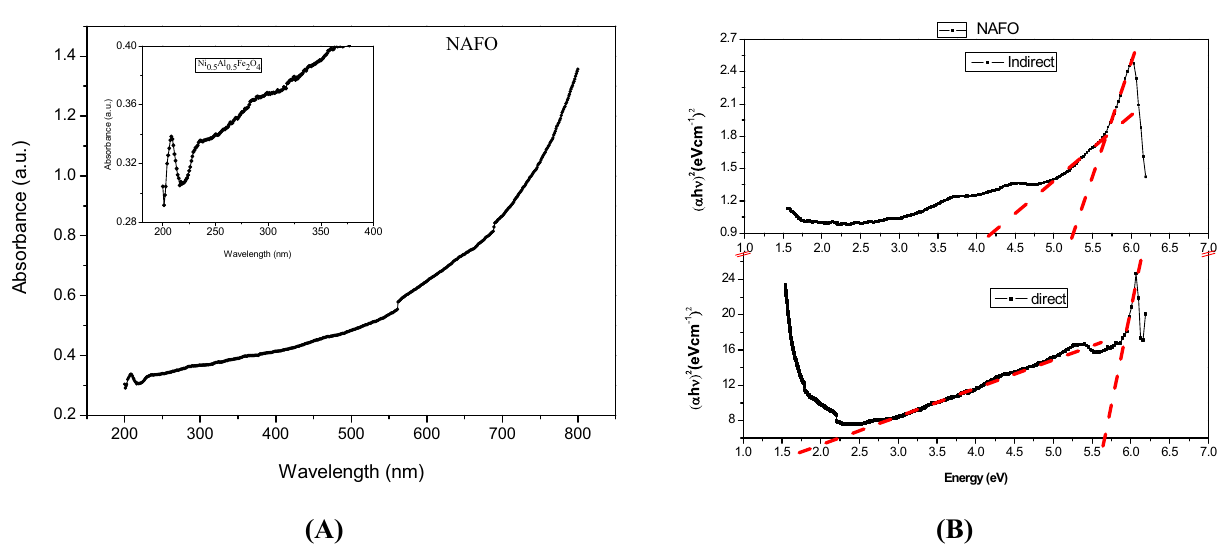
Figure 6. ( A ) UV–vis spectrum ( B ) Tauc’s plot of (α h υ ) 2 (eVcm −1 ) 2 vs photon energy (eV) of NAFO